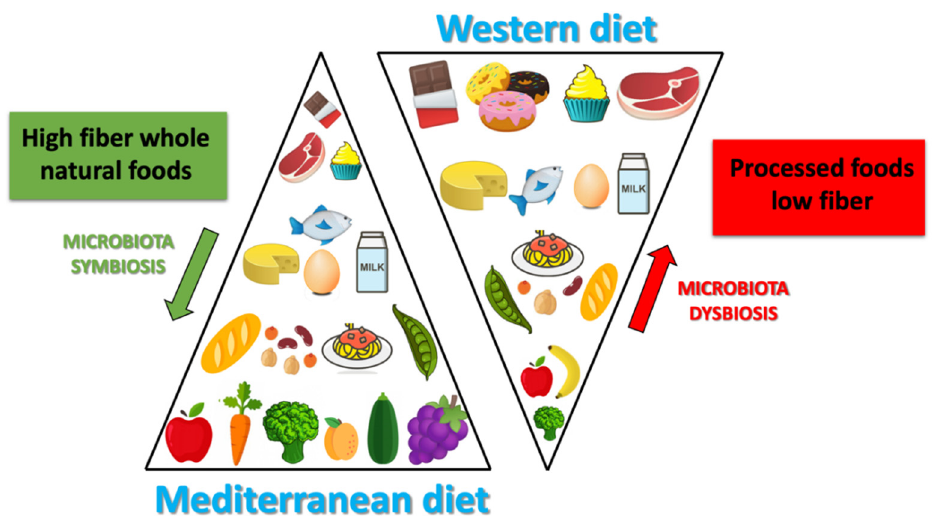
Figure 3. Differences between Mediterranean diet and Western diet.